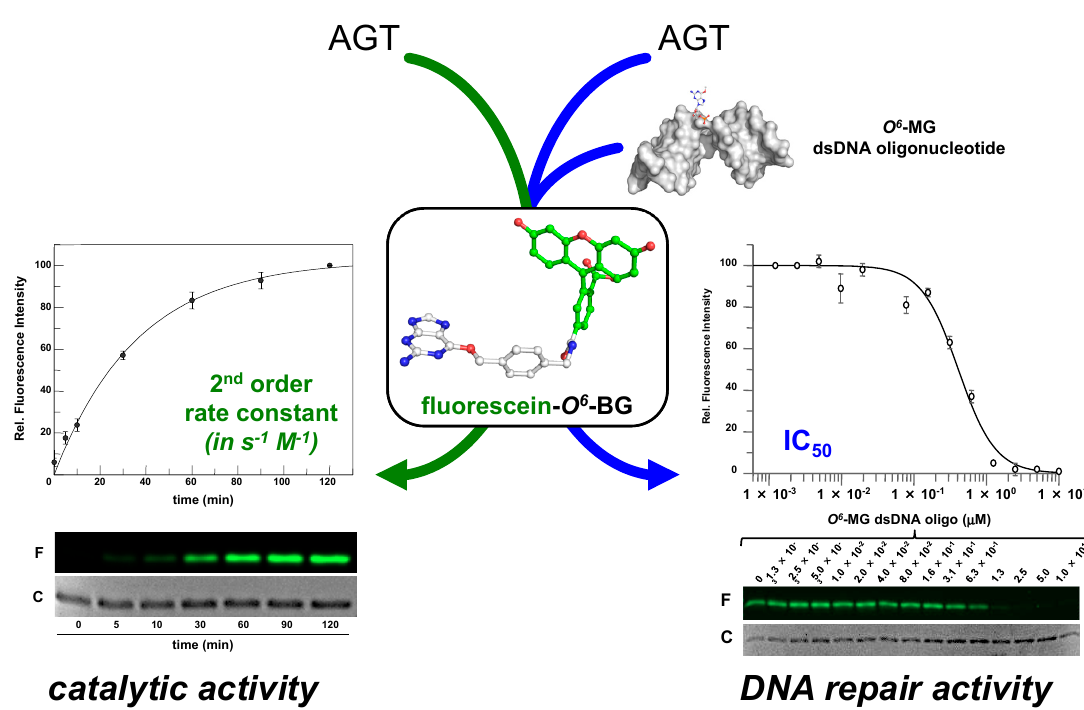
Figure 3. Innovative fluorescent AGT assay. The substrate could be used alone for the determination of the AGT catalytic activity, or in combination with a competitive non-fluorescent substrate (alkylated-DNA). In the latter case, an indirect measure of the DNA repair activity on natural substrates is determined (adapted from